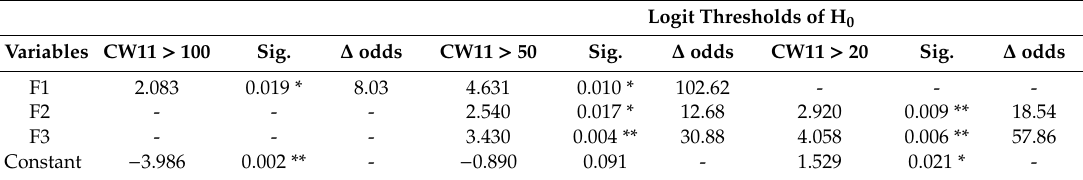
Table 8. Variables used in the logistic regression